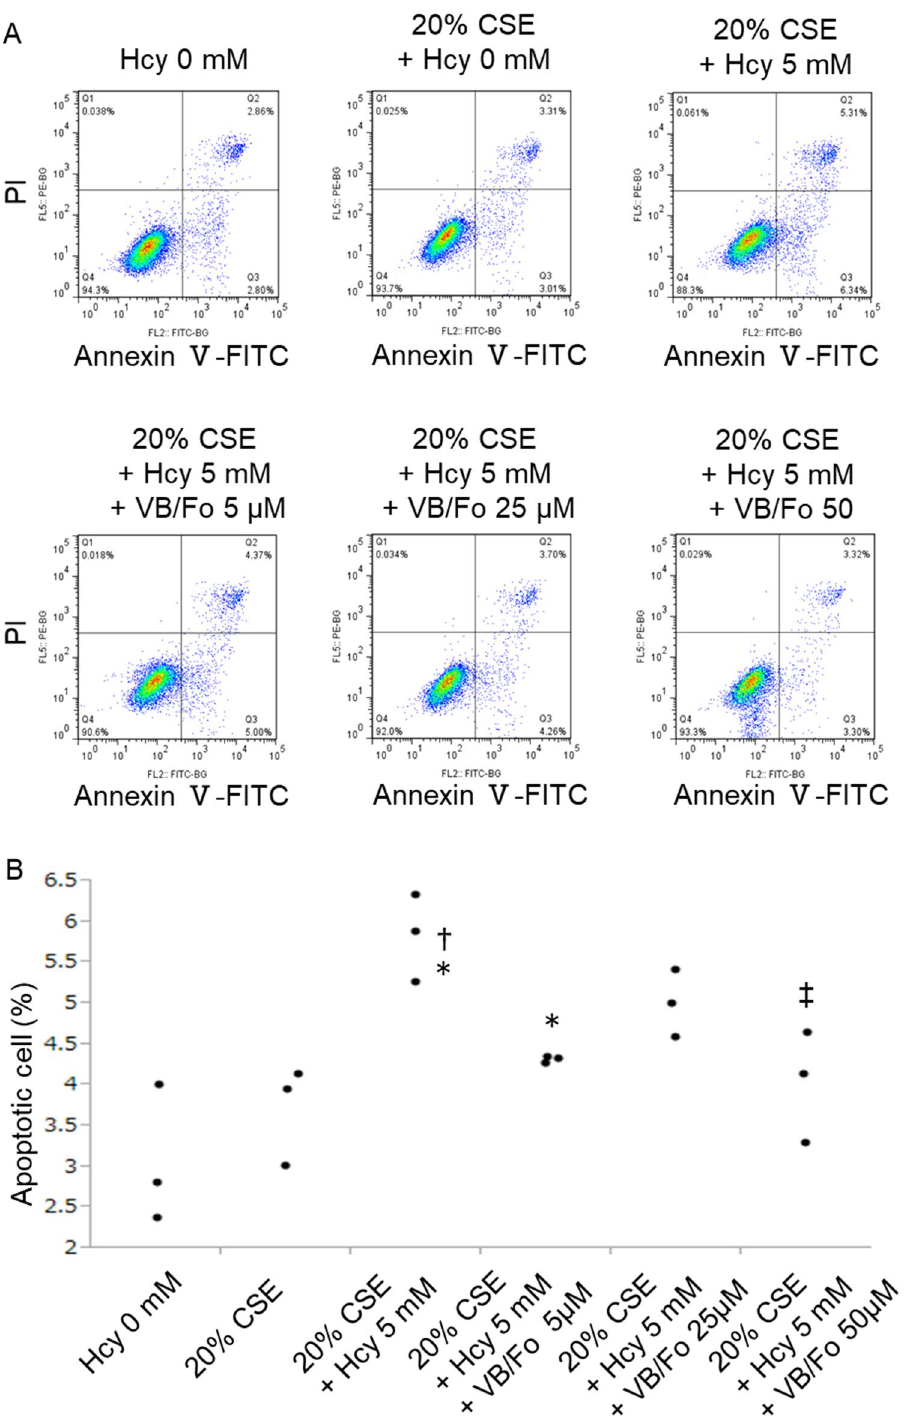
Figure 6. Vitamin B12 (VB) and folate (Fo) reduced the proportion of apoptotic A549 cells induced by homocysteine and cigarette smoke extract (CSE). To investigate the effect of vitamin B12 and folate supplementation on the apoptosis induced by homocysteine/CSE, A549 cells were pretreated with the same concentration of vitamin B12 and folate adjusted to 5 ‒ 50 μM for 12 h, followed by stimulation with 5 mM homocysteine plus 20% CSE. ( A ) The proportion of apoptotic A549 cells were evaluated using Annexin V/propidium iodide double staining. Apoptosis was regarded as the cell percentage in the Q3 quadrant. ( B ) Quantified data of flow cytometry. Quantified data of flow cytometry show that simultaneous stimulation with homocysteine 5 mM and 20% CSE increased the proportion of apoptotic cells. However, the proportion of apoptotic cells was decreased as the concentration of Vitamin B12 and folate increased. n = 3 in each group. Differences between groups were examined using Tukey–Kramer test. *P < 0.05 vs homocysteine 0 mM, † P < 0.05 vs 20% CSE, ‡ P < 0.05 vs 20% CSE + homocysteine 5 mM. CSE cigarette smoke extract, Fo folate, Hcy homocysteine, PI propidium iodide, VB vitamin